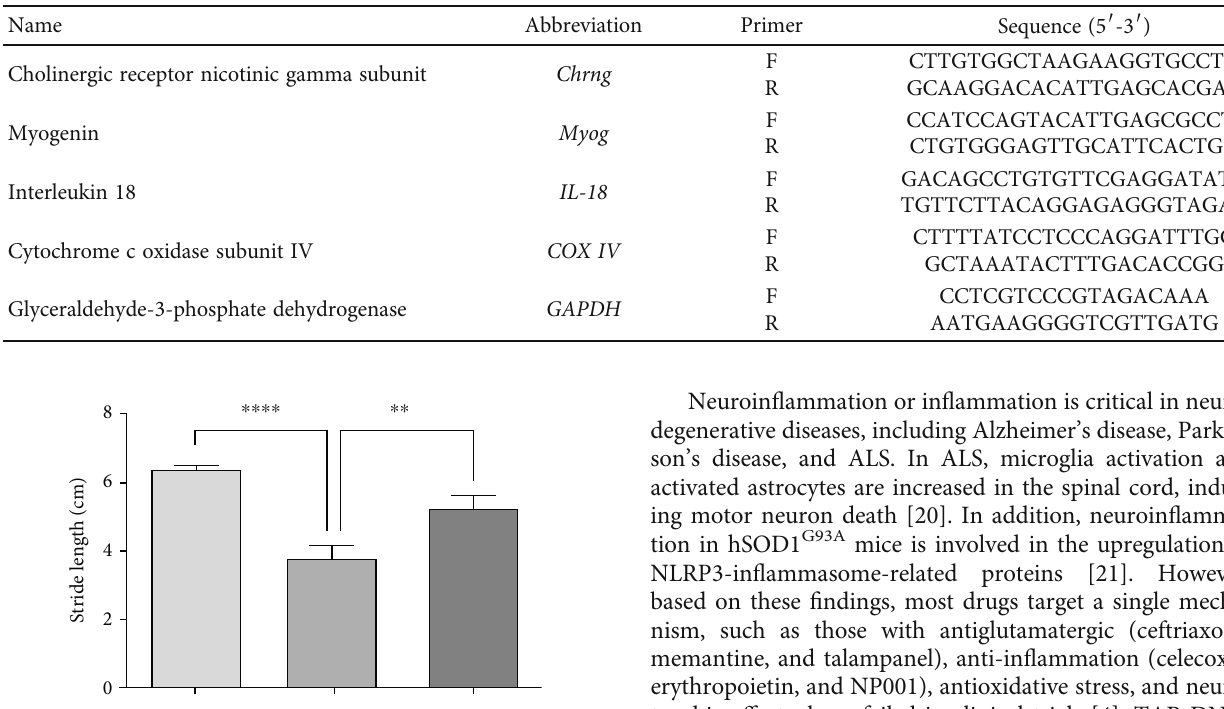
Table 1: The primer sequence for real-time reverse transcription PCR.